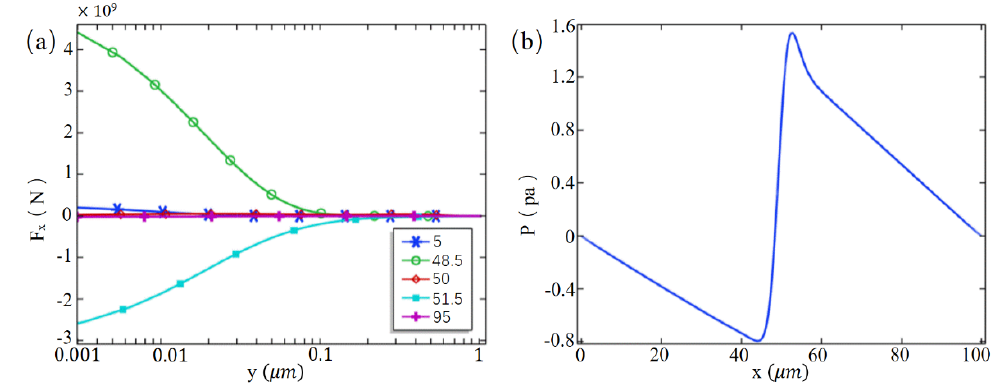
Figure 6. ( a ) Horizontal electric field force in the y direction at di ff erent coordinate values of the x-axis ( V cm = 400 mV); ( b ) The curve of the pressure along the line of symmetry of the channel.